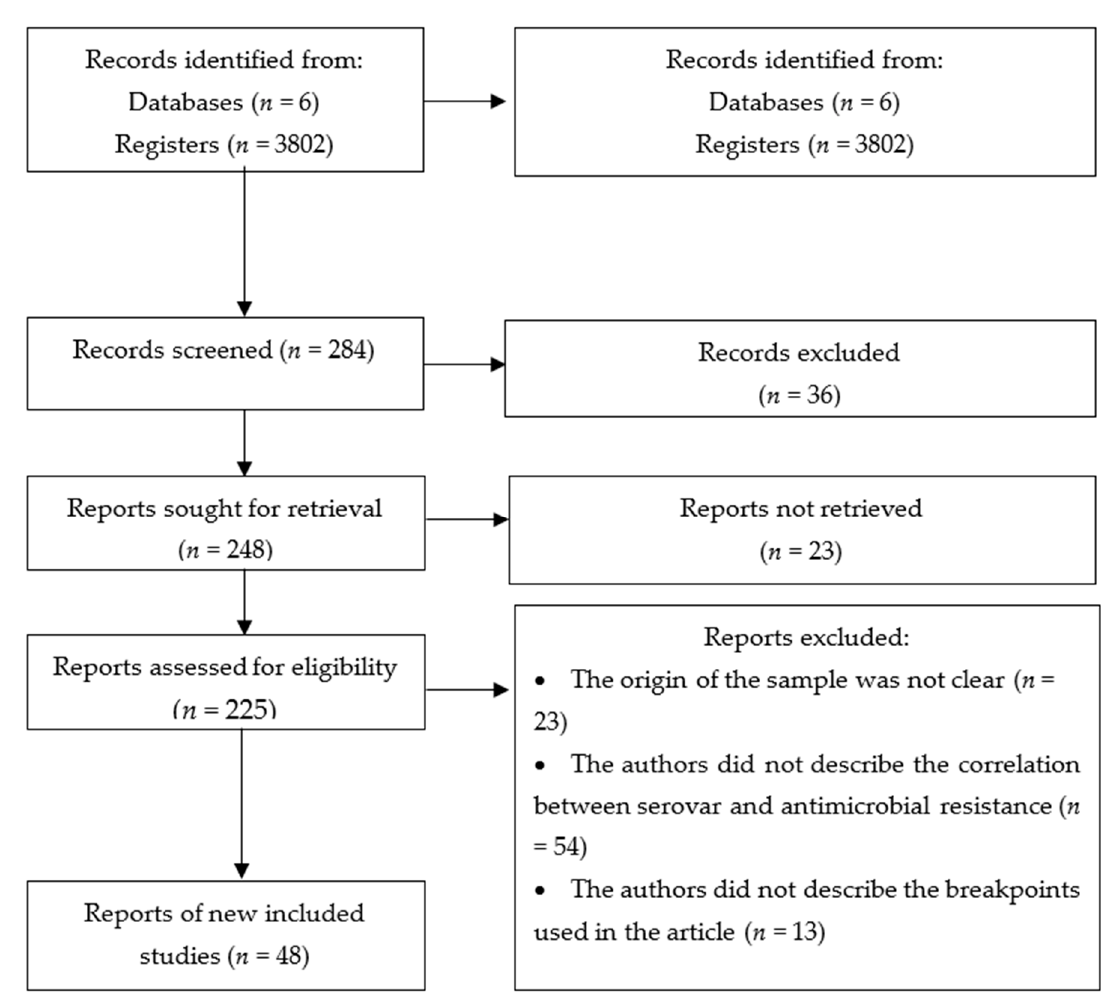
Figure 1. Strategy for selection of eligible articles. Flowchart made based on [31,32].